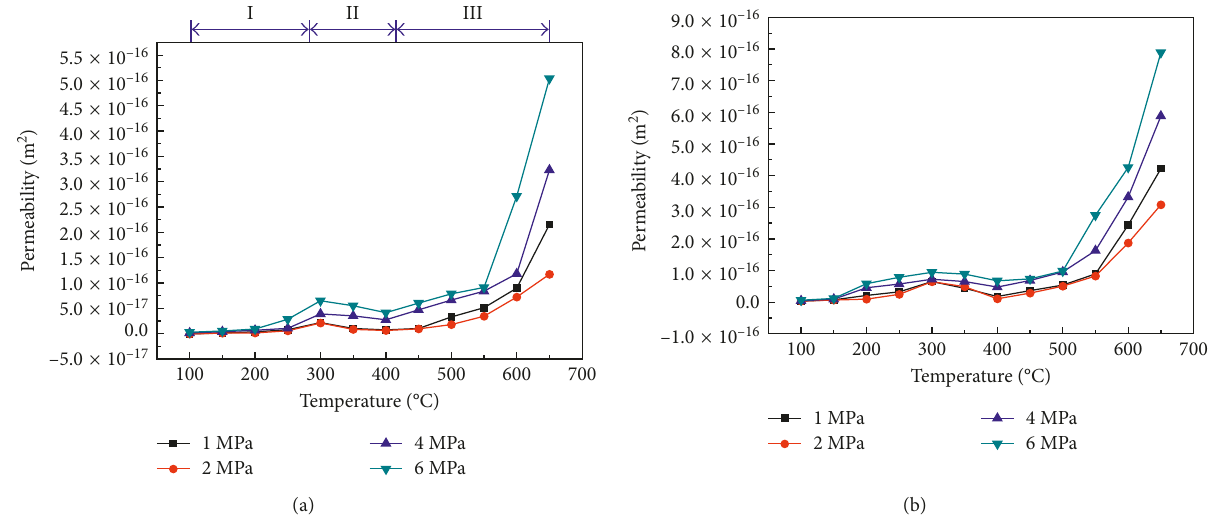
Figure 4: The permeability variation of granite specimen with the low initial damage. (a) The permeability of granite specimen when the initial axial compression is 60% of UCS. (b) The permeability of granite specimen when the initial axial compression is 70% of